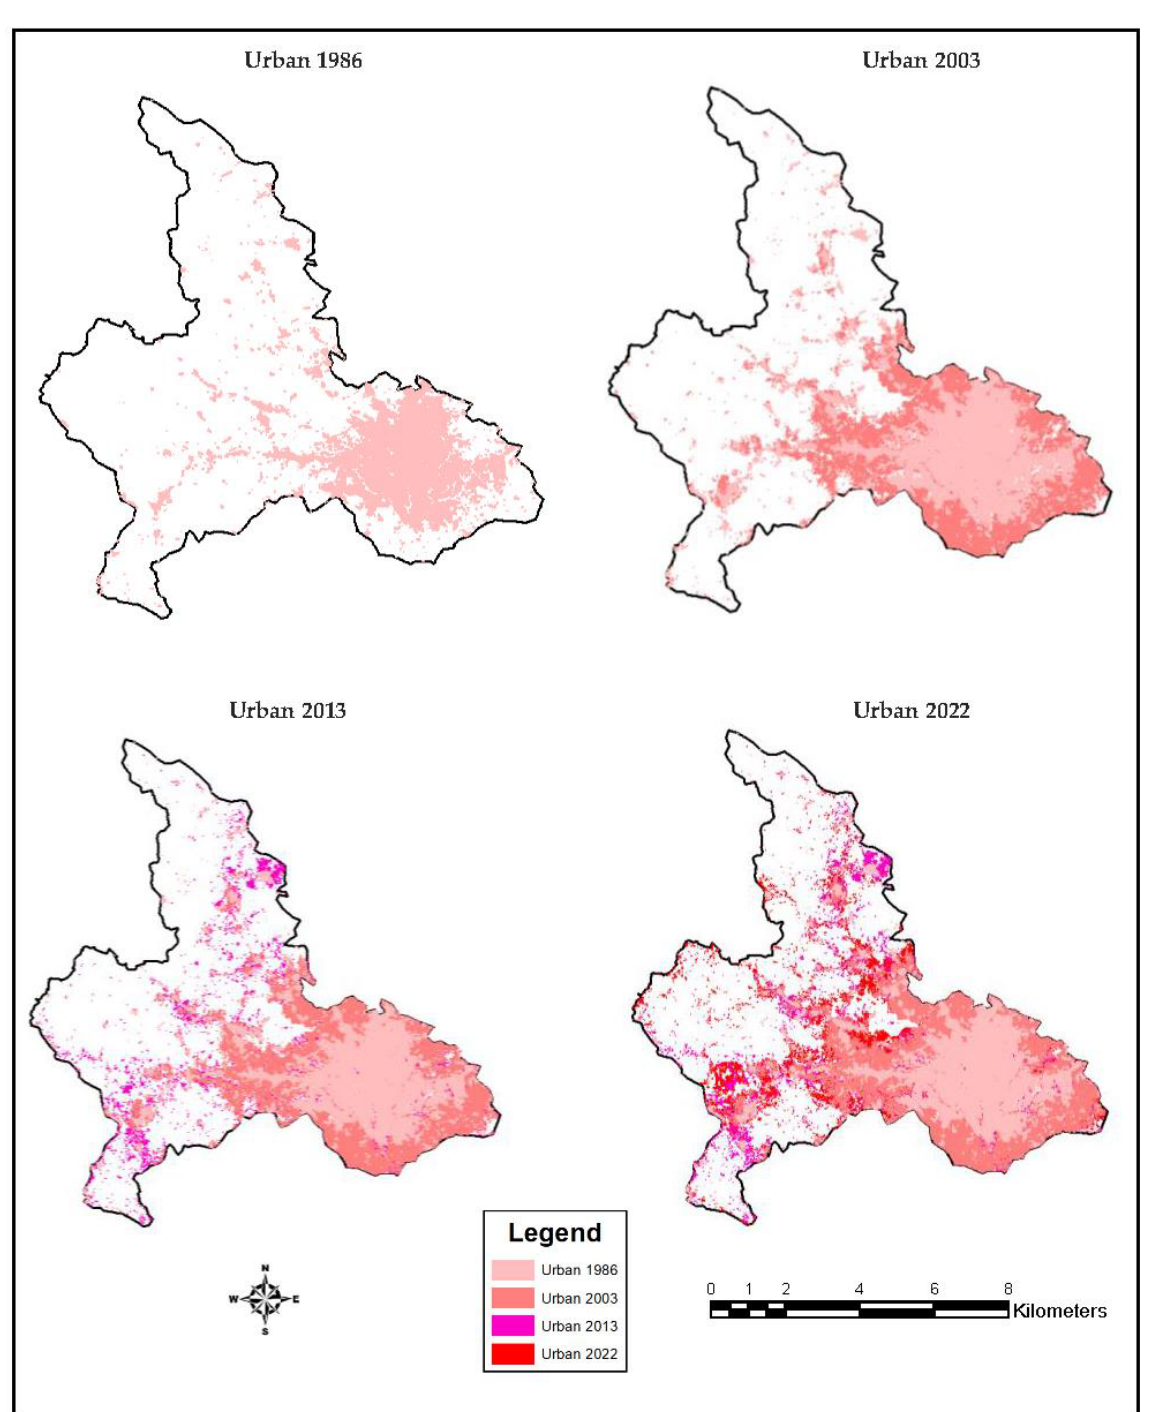
Figure 10. Urban extent maps.